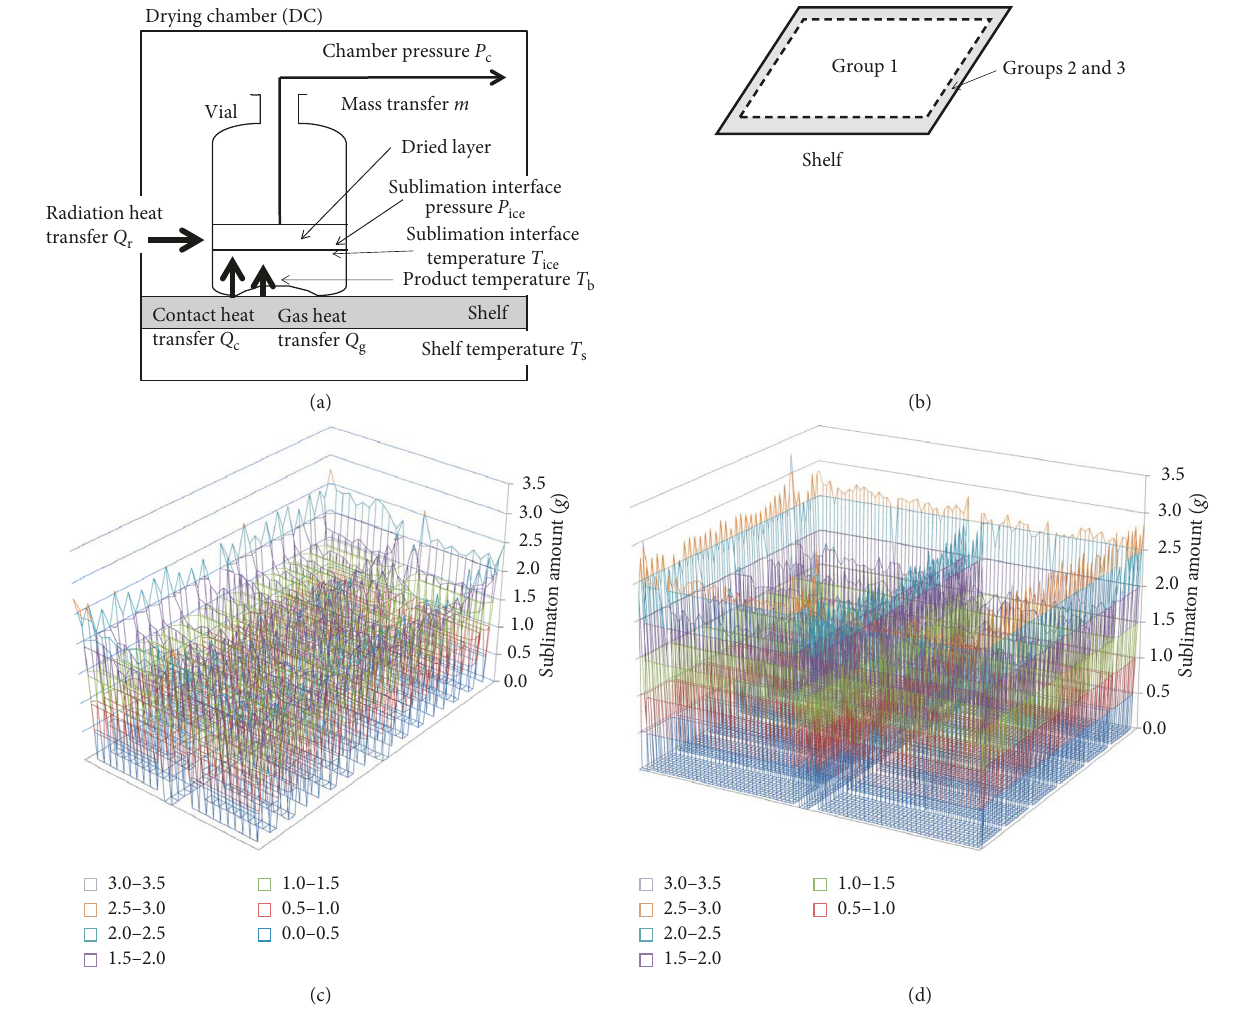
Figure 3: (a) Heat and mass transfer model for lyophilization. (b) Categorization of vials on the shelf. Group 1: vials are placed in the central part of the shelf; Groups 2 and 3: vials are placed in the second and the first rows on each side of the shelf, respectively. This categorization is based on the literature [27]. Distribution of sublimed amount of ice from the vials on the shelf. (c) 1,008 vials, (d) 6,000 vials. Data were redrawn based on [55]. − 5 ° C, the dashed curve shifts to the positive direction of dm / dt axis. In order to avoid the reduction of dm / dt , the P c should be maintained to the lower pressure below 20 Pa.